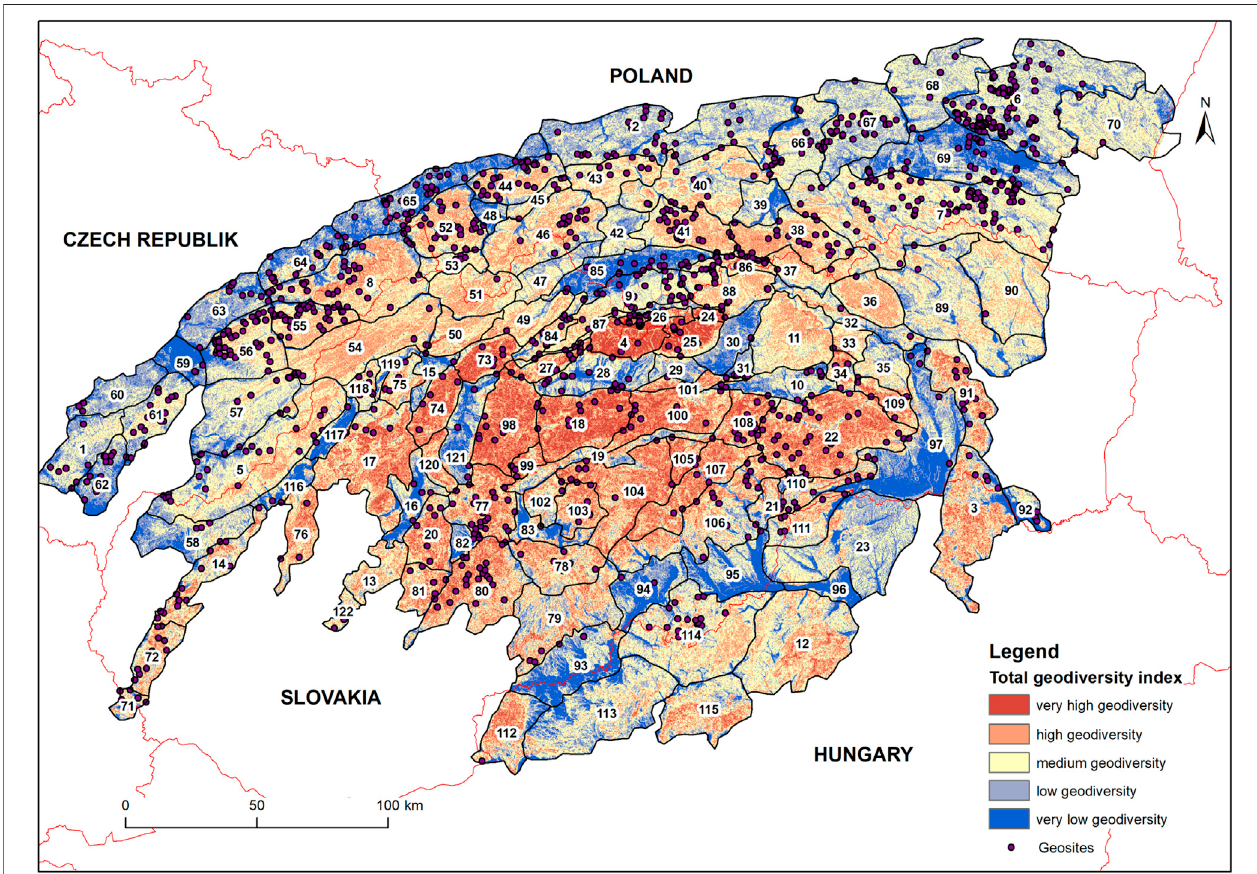
FIGURE 9 | Geodiversity of the Western Carpathians vs location of geosites in the area. For numbers of mesoregions, see Figure 2 . Source: own research.